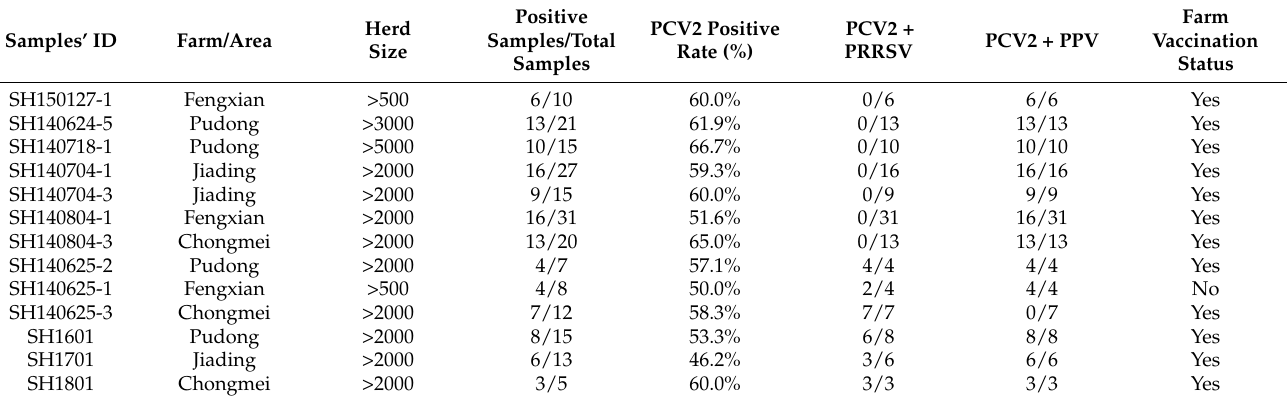
Table 2. Positive rate of PCV2 and its co-infection status with PRRSV and PPV from samples collected from various pig farms (Shanghai, China) between 2014 and